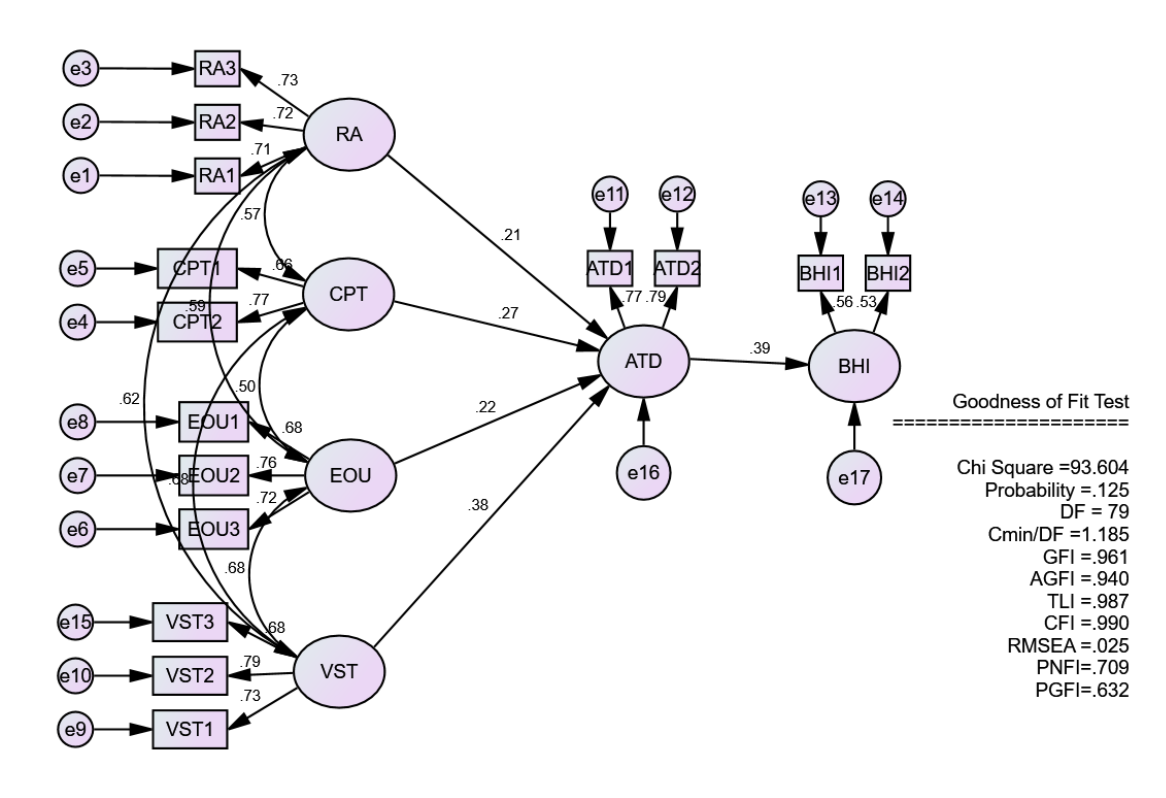
Figure 2: Estimation